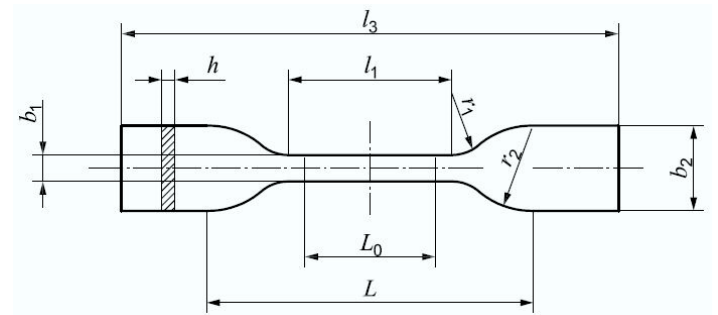
Figure 2. ISO 527-2 type 5A test specimen. Table 3. Test specimen dimensions according to ISO 527-2 type 5A.